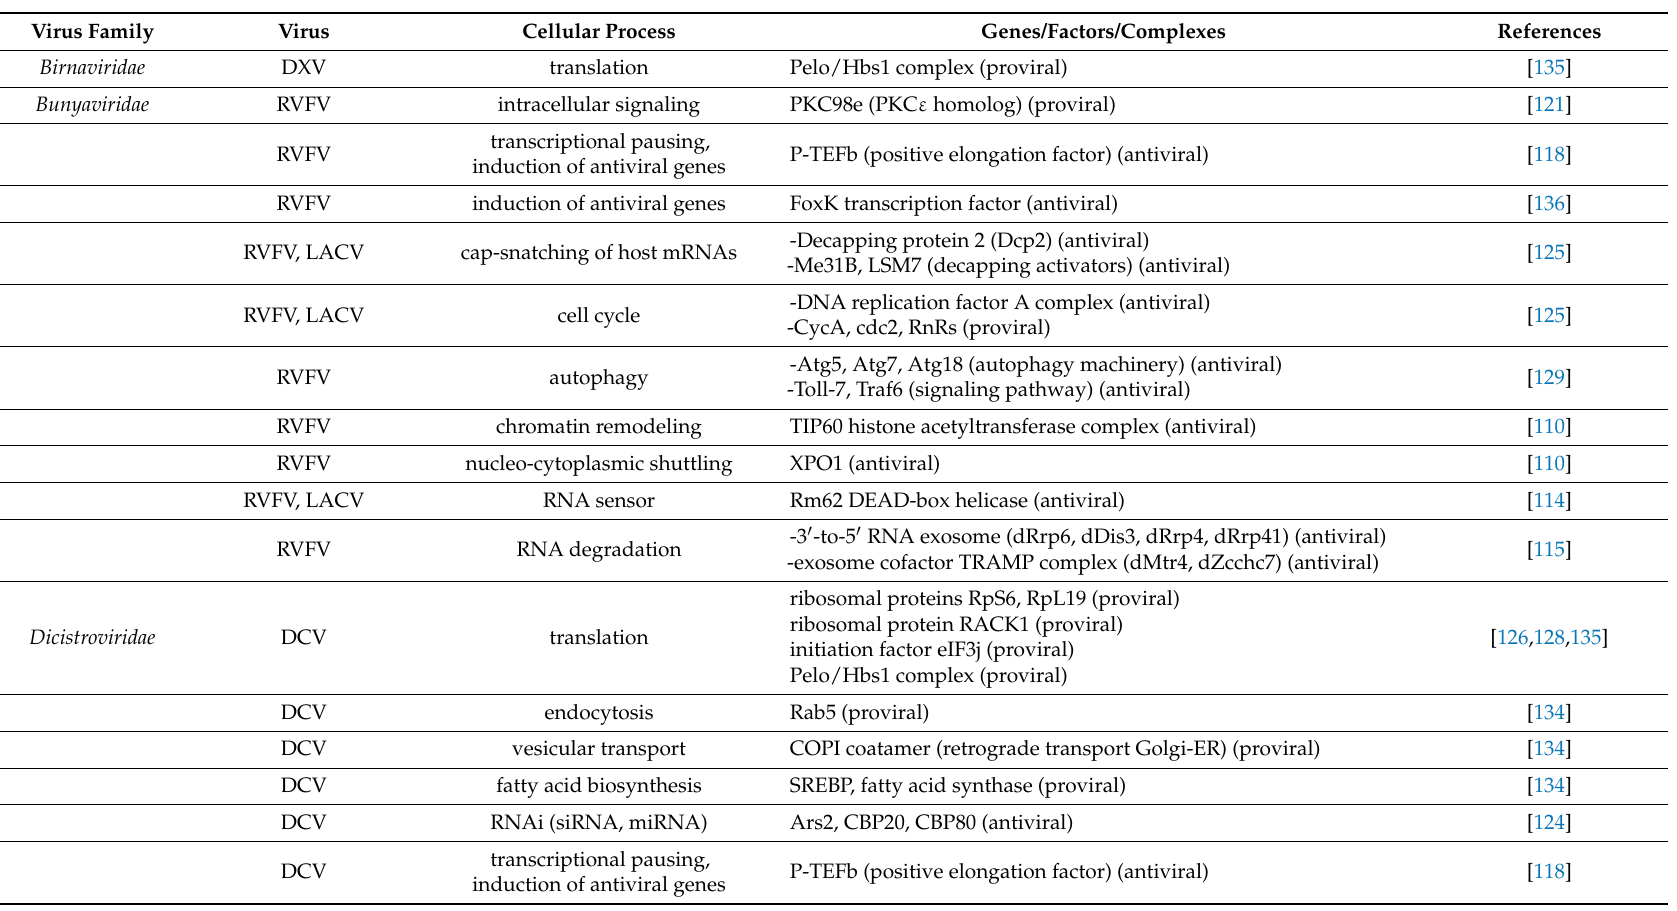
Table 1. Overview of genome-wide or more targeted RNAi screens to identify cellular factors that affect virus infection in Drosophila tissue culture cells. Identification of proviral genes (encoding viral sensitivity factors) and antiviral genes (encoding viral resistance factors) is indicated. Only genes that have been validated in adult flies are included. Abbreviations: SINV, Sindbis virus; DXV, Drosophila X virus; RVFV, Rift valley fever virus; LACV, LaCrosse virus; DCV, Drosophila C virus;